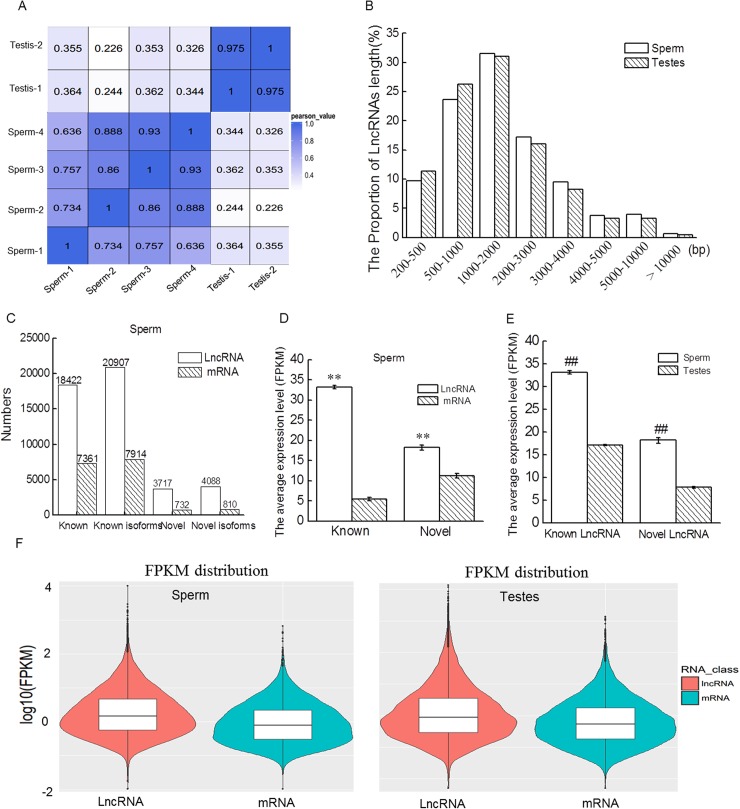
LncRNAs expression profiles in mouse mature sperm.(A) Correlation analysis of all sequencing samples. (B) The numbers of lncRNAs according to length in mice testes and mature sperm. (C) The numbers of lncRNAs and mRNAs in mature sperm. (D) The average expression levels of known and novel lncRNAs and mRNAs in mice mature sperm. (E) The average expression levels of known and novel lncRNAs in mice testes and mature sperm. (F) The violin graph of lncRNAs and mRNAs in in mice testes and mature sperm. **P < 0.01 compared with mRNA, ##P < 0.01 compared with testes.